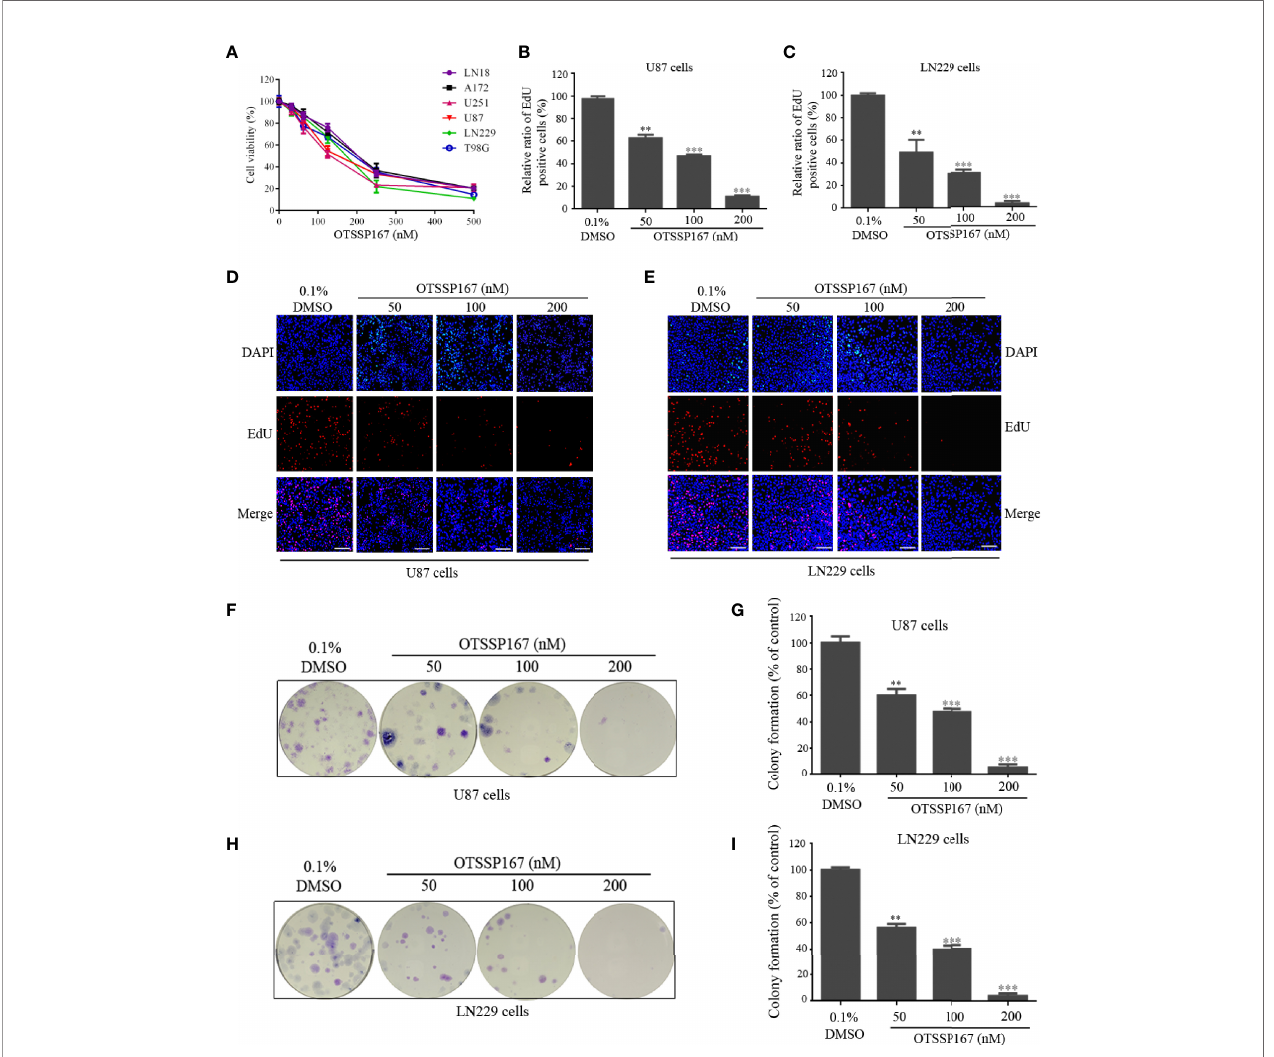
FIGURE 1 | OTSSP167 inhibits GBM cell proliferation and colony formation. (A) CCK-8 viability analysis of cells treated with six OTSSP167 concentrations, including 0 nM, 31.25 nM, 62.5 nM, 125 nM, 250 nM, and 500 nM for 72 h. (B – E) The U87 and LN229 cells were treated with indicated concentrations of OTSSP167 for 24 h, and the EdU assay was performed to assess cell proliferation. Panels (B, C) show the results of the quantitative analysis of the EdU test; panels (D, E) show the representative images of EdU analysis after OTSSP167 treatment of the U87 and LN229 cells. (F – I) OTSSP167 inhibits colony formation in U87 and LN229 cells in a dose-dependent manner. Quantitative analysis of the results of the colony formation experiment was performed. All the Data are presented as means ± SEM. ** P < 0.01, *** P < 0.001 compared with the 0.1% DMSO treated